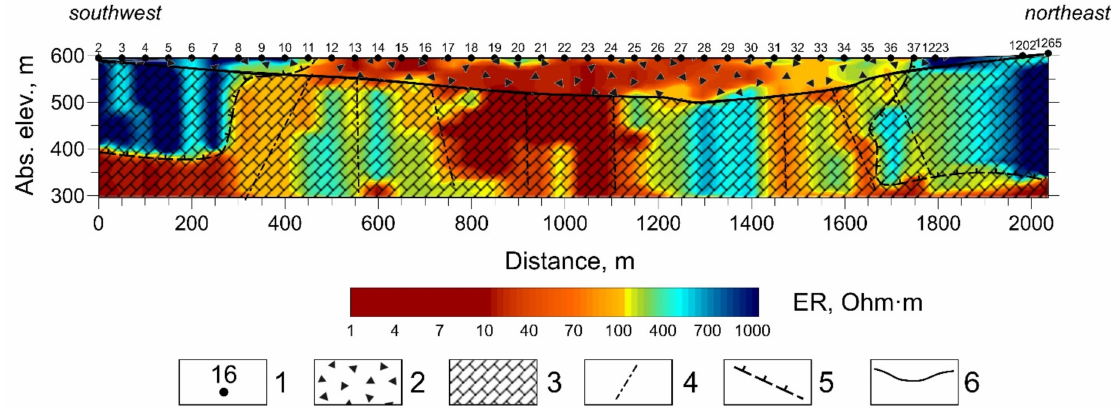
Figure 7. Geoelectric section along profile No. 1 with interpretation elements (1—item TEM and its number; 2—technogenic deposits (tailings); 3—carbonate rocks; 4—fault axes according to TEM data; 5—permafrost boundary according to TEM data; 6—relief surface before the start of filling the